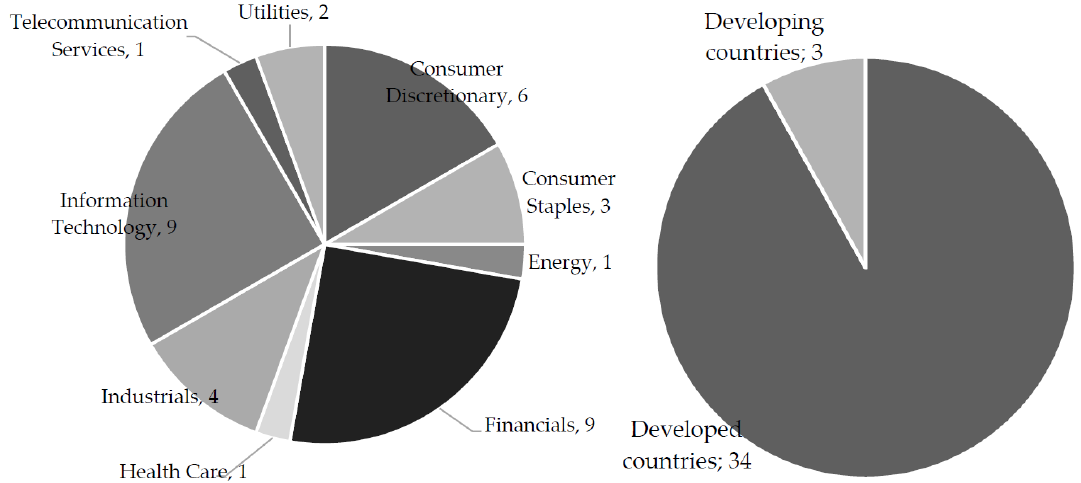
Figure 3. Structure of sample companies by industry ( left ) and by country category (developed and developing countries: right ). Source: calculated and built by the authors.